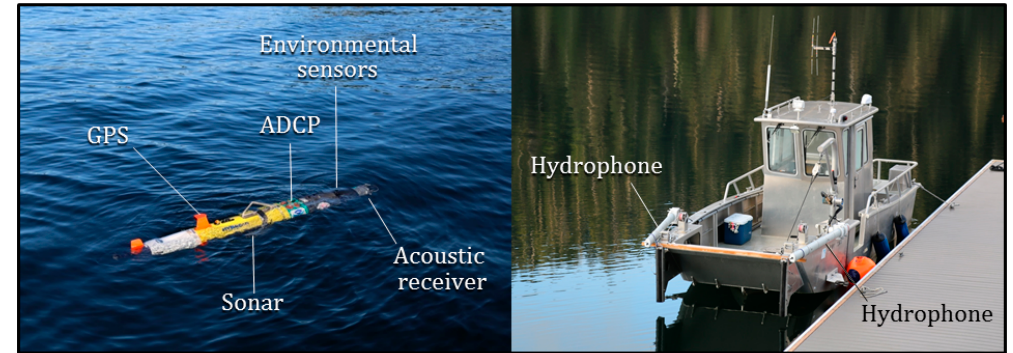
Figure 2. Remus 100 autonomous underwater vehicle ( left panel ) used during field trials in marine waters of southeastern Alaska during 2016. The vehicle was equipped with payload control hardware and software (internal), a receiver and hydrophone for detecting and recording acoustic transmitters, an acoustic Doppler current profiler (ADCP), environmental sensors, a side-scan sonar, and a GPS receiverforcollectingpositioningdata. Aboatequippedwithanacousticreceiveranddualhydrophones was used to conduct concurrent surveys ( right panel ). The hydrophone struts were lowered into the water and vertically oriented during tracking, with the hydrophones submerged to a depth of 1 m.